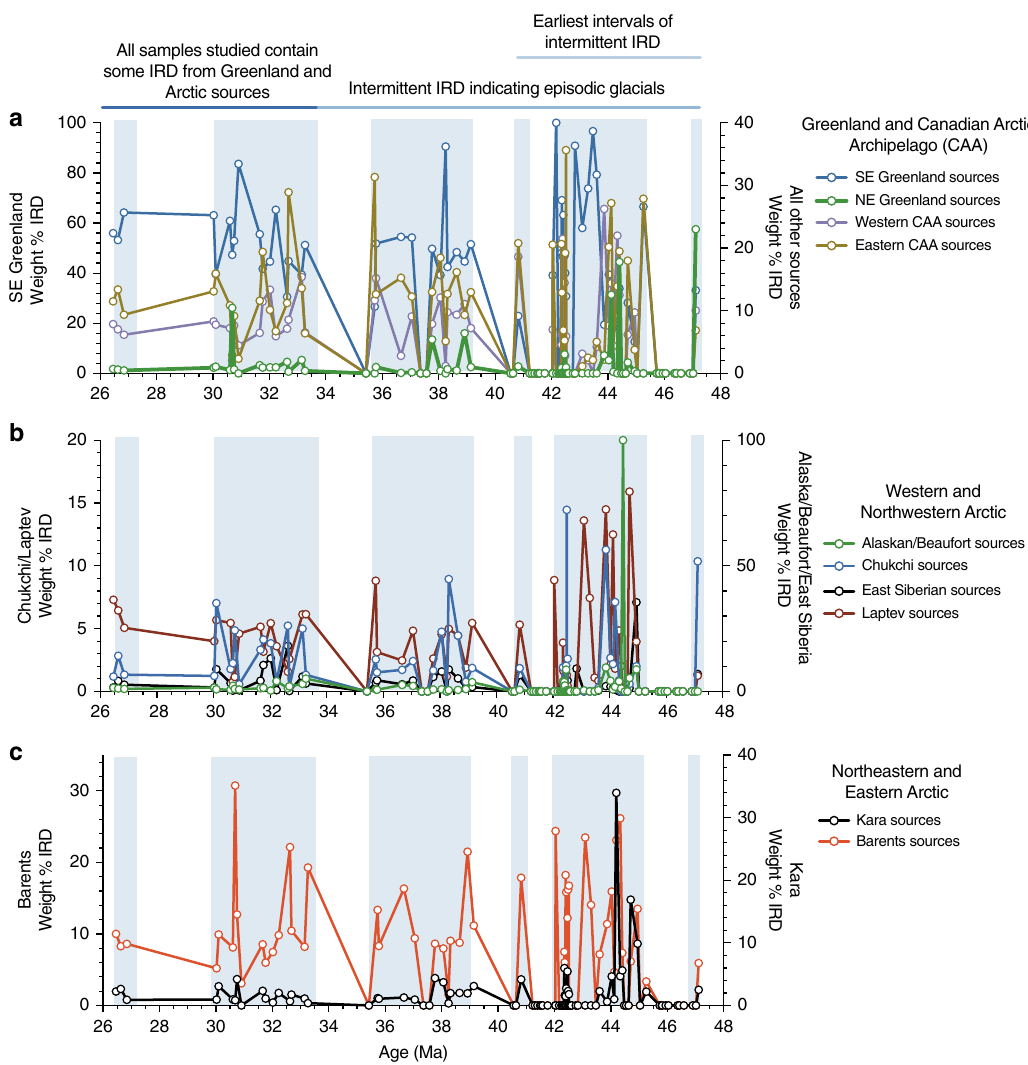
Fig. 2 Greenland and Pan-Arctic sources of ice-rafted debris from 48 – 26 Ma. a Greenland and Canadian Arctic Archipelago (CAA) sources; b Western and Northwestern Arctic sources; c Northeastern and Eastern Arctic sources. Fluctuations in numbers of Fe oxide grains from various sources indicate ephemeral glaciations on Greenland at times when there was sea ice drifting to Site 913 from multiple regions of the Northern, Western, and Southern Arctic. The ice-rafted debris attributable to speci fi c sources is based on chemical fi ngerprinting of Fe oxide grains. Data are in Supplementary Data 2. NE Greenland = source area (SA) 1, 35 in Fig. 1; SE Greenland = SA 42, 43, and 46; Eastern Canadian Archipelago (CAA) = SA 2 – 6, 24 – 28; Western CAA = SA 5, 7 – 8, 25; Kara = SA 12, 14 – 16, 36,37; Laptev = SA 17 – 18, 23; Chukchi = SA 38 – 41; East Siberian = SA 19 – 22; Alaskan/Beaufort = SA 9 – 11, 13; Barents = SA 29 – 34. Weight % = percent X number of Fe oxide grains matched to a source/10 where 10 is a very conservative estimate of the number of grains that are very signi fi cant, in order to avoid high percent values where there are low numbers of Fe oxide grains matched. Zero values indicate a sample did not contain Fe grains from a source in the region. Vertical blue bars mark intervals with samples containing IRD. The Eocene-Oligocene boundary is ~34